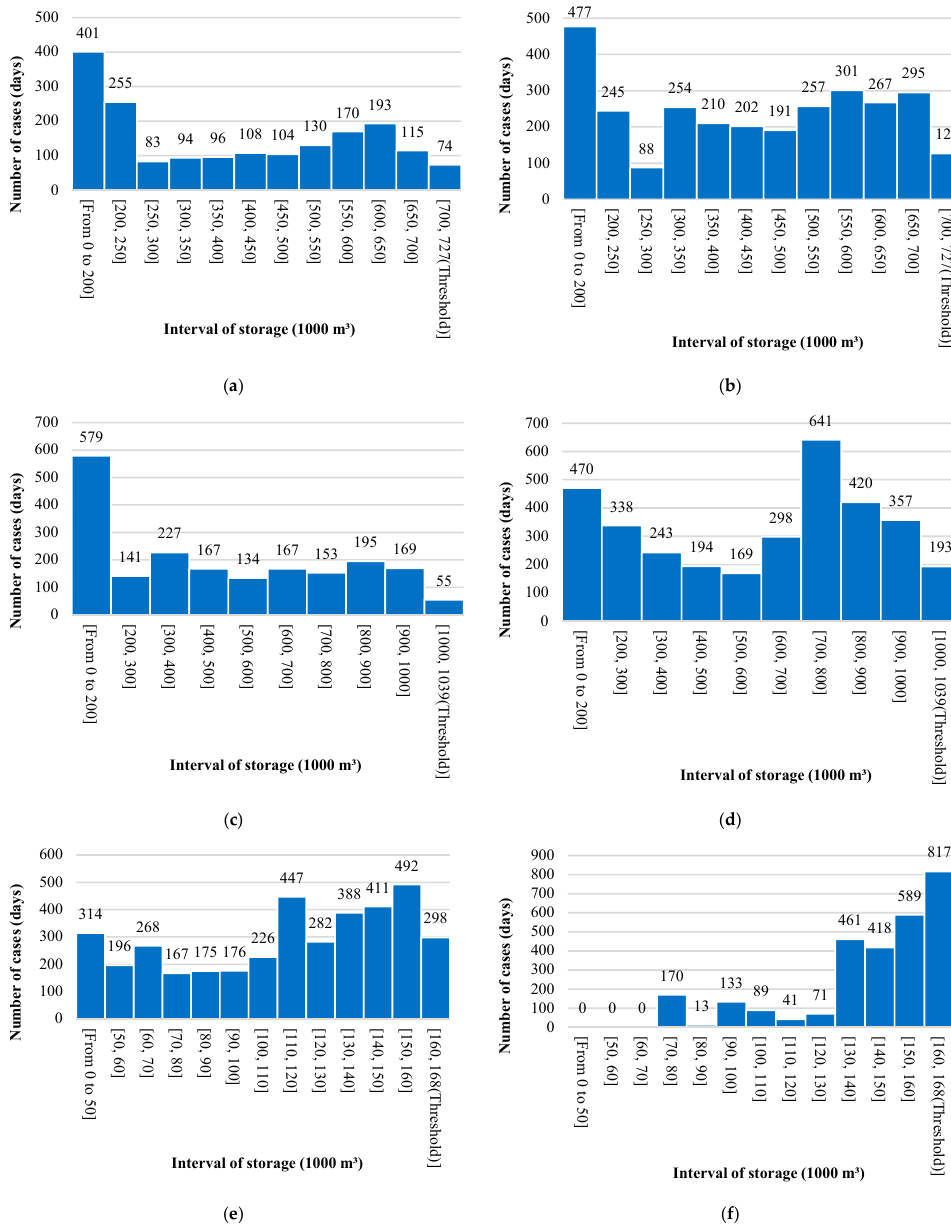
which the water volume decreased below the threshold level. The X -axis indicates the interval of storage, and the Y -axis indicates the number of days when the daily water volume is below the